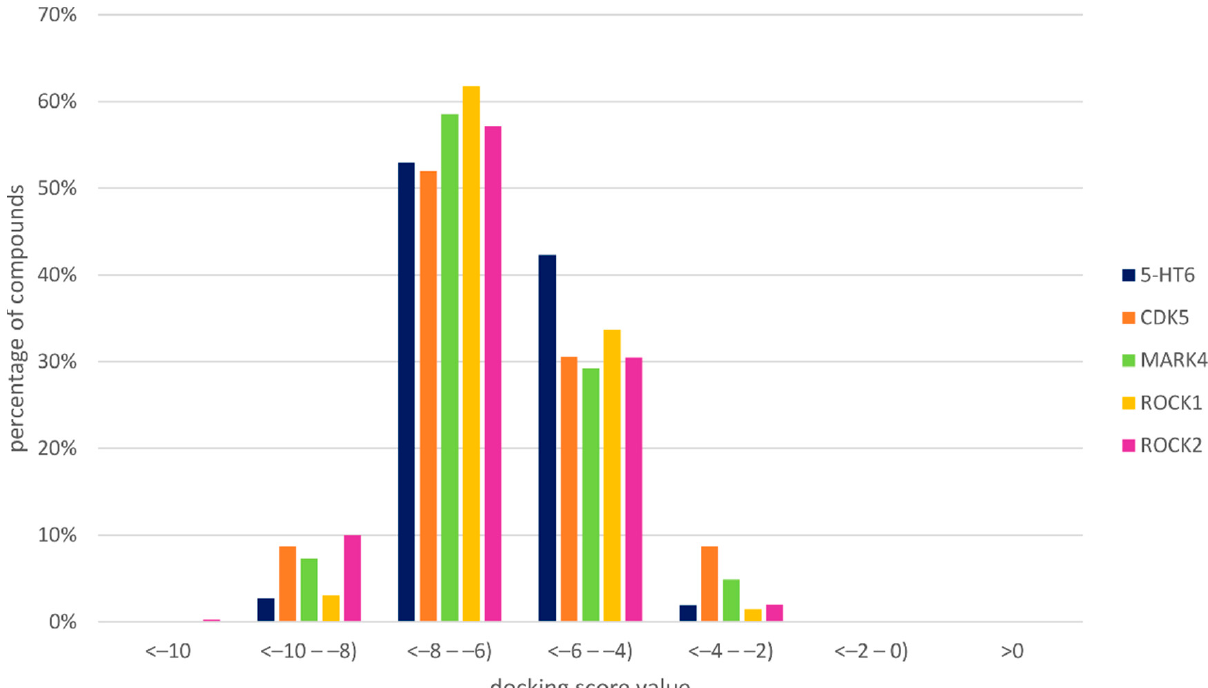
Figure 5. Distribution of docking score values to 5-HT 6 R homology model.